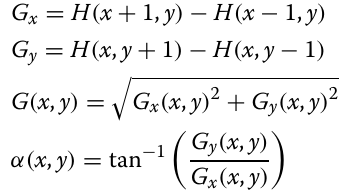
used to train the Bayes kernel classifier. This Bayes clas- sifier is combined with the multiple SVM classifiers as an integrated